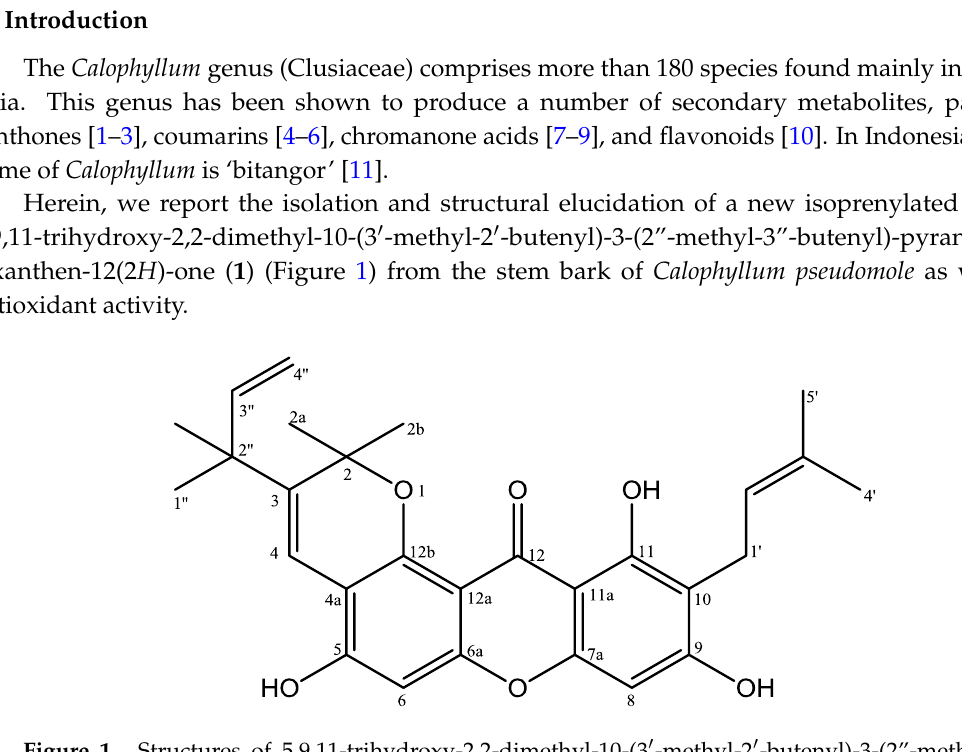
Figure 1. Structures of 5,9,11-trihydroxy-2,2-dimethyl-10-(3′-methyl-2′-butenyl) -3-(2″- methyl-3″-butenyl)pyrano[2,3-a]xanthen-12(2 H )-one ( 1 ).